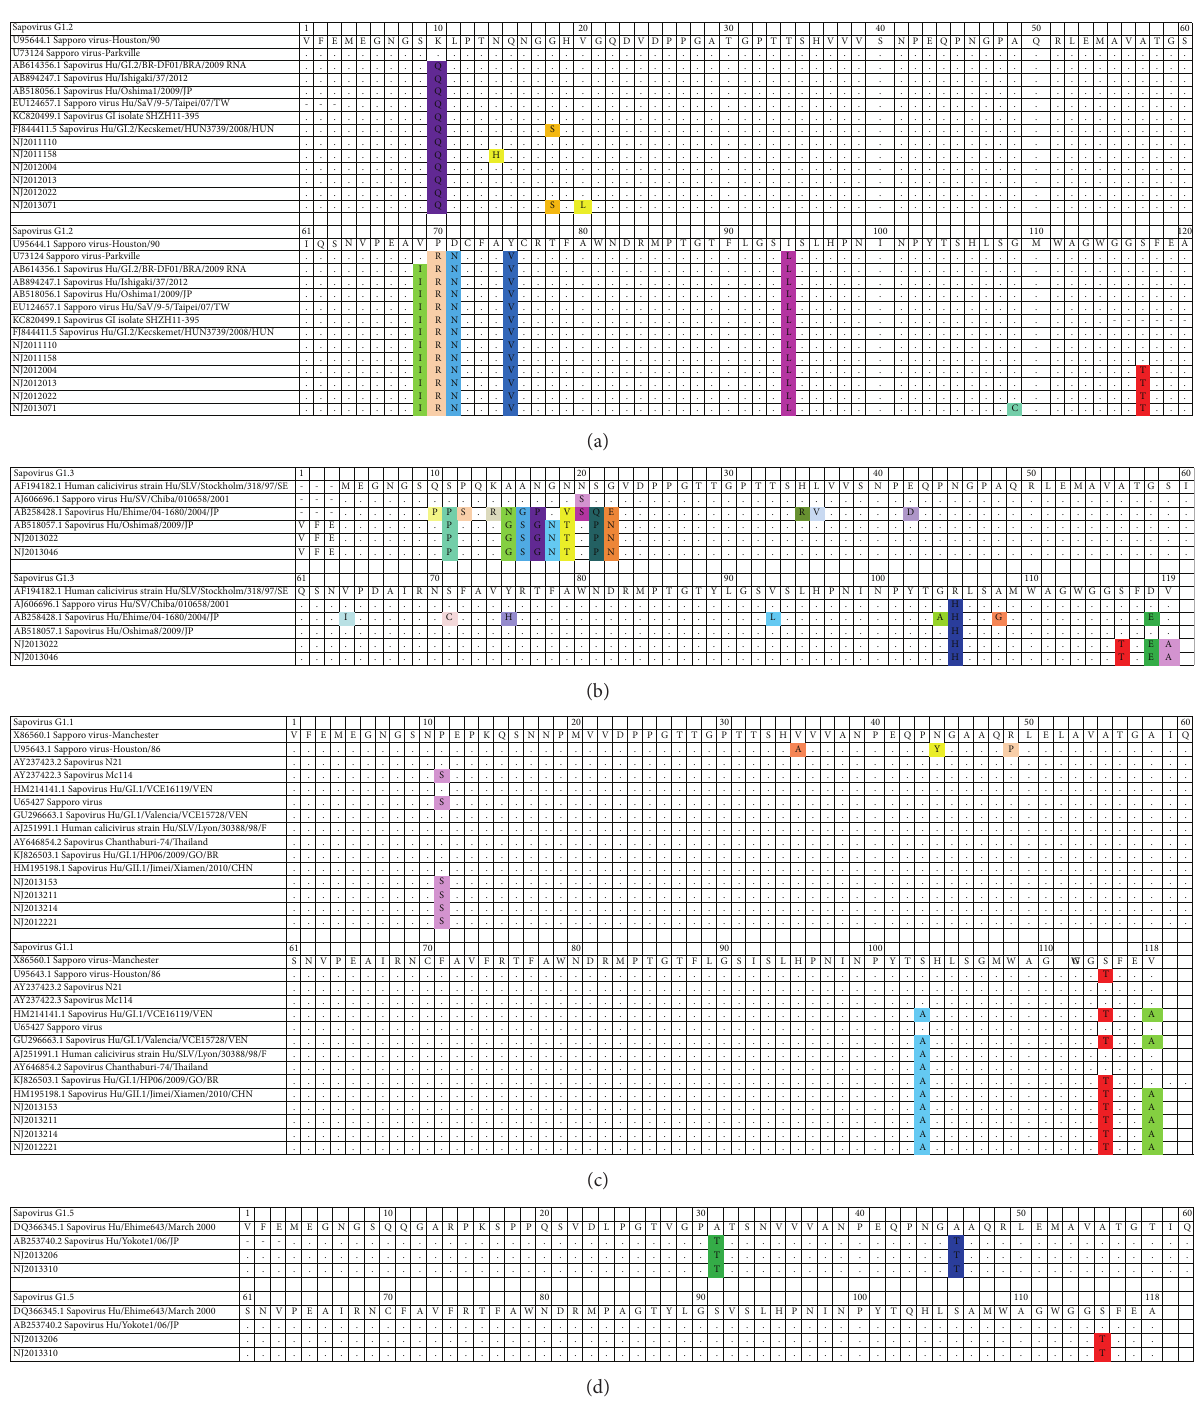
Figure 2: Amino acid substitutions of Nanjing strains compared to reference strains of (a) Sapovirus G1.2, (b) Sapovirus G1.3, (c) Sapovirus G1.1, or (d) Sapovirus G1.5, respectively. GI.1, GI.2, GI.3, and GI.5 were genotypes. Different colors were used for marking different substitutions in each